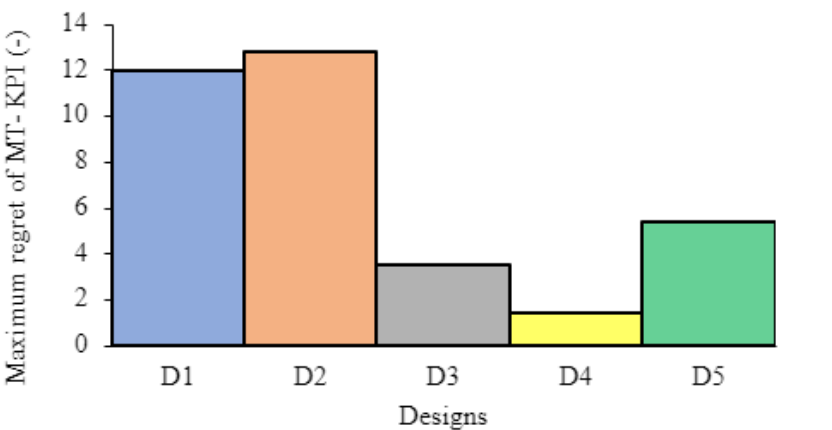
Figure 7. Calculated maximum-regret for MT-KPI of the five designs. A low value shows the most robust design.